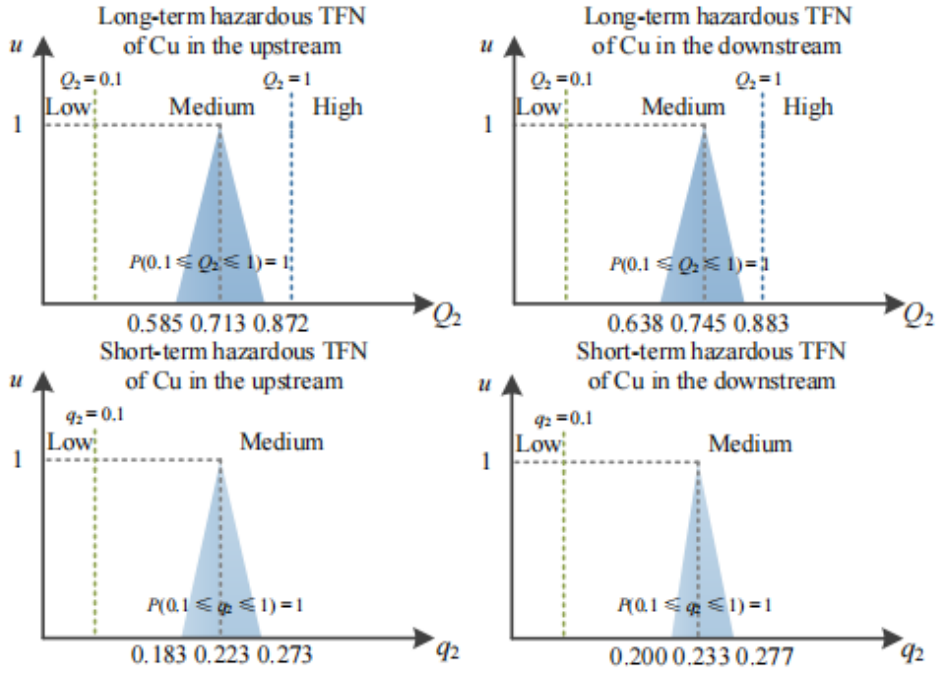
Figure 9. Hazardous TFNs of Cu after dam